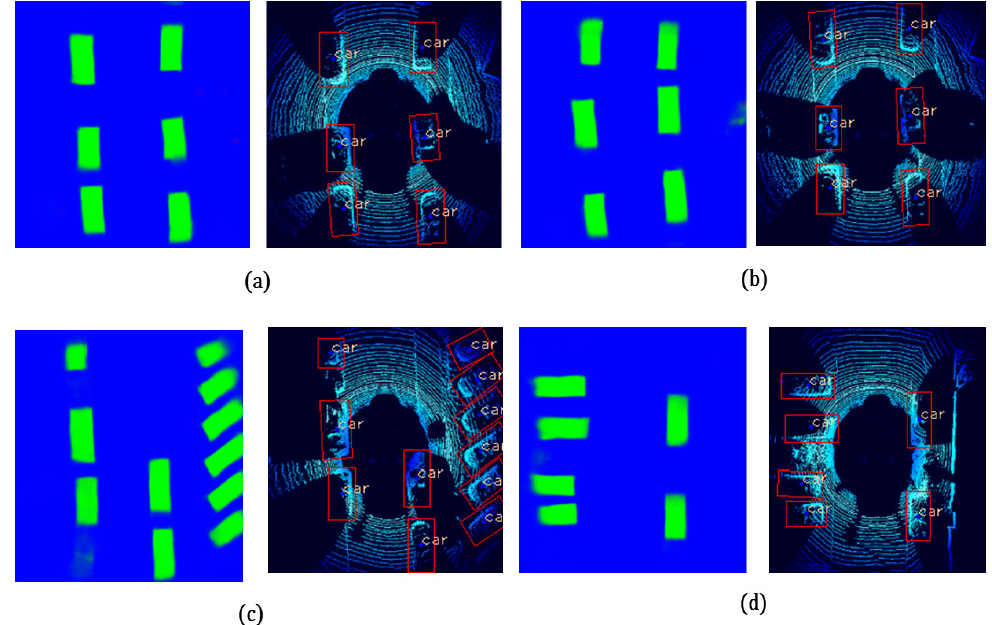
Figure 8. ( a – d ) shows samples of prediction on the left-hand side and extracted contours for the car class on the right-hand side. Subfigures ( a , b ) shows the simple scenarios, and ( c , d ) shows the images where the proposed model is able to achieve accurate results in more complex scenarios with rotated bounding